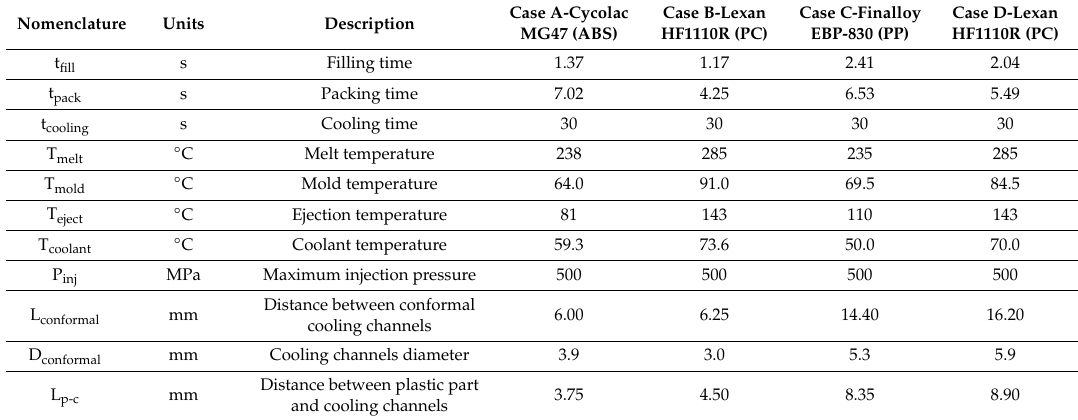
Table 6. Definition of the filling and cooling stage technological and geometrical